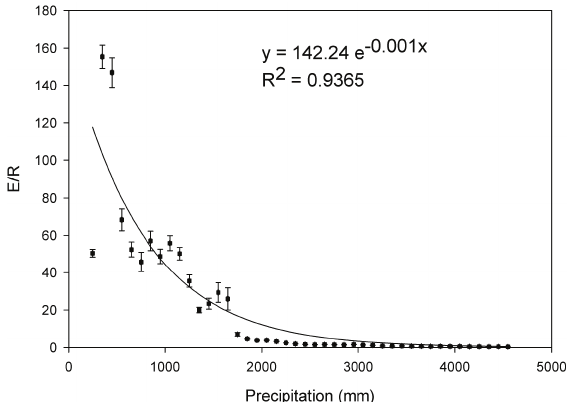
999 Fig. 10. Modeled evapotranspiration-runoff ratio (E/R) along the annual precipitation 1000 gradient across the Mesoamerican region. Each point represents a 100 mm annual 1001 Fig. 10. Modelled evapotranspiration-runoff ratio ( E/R ) along the precipitation class. Bars show standard error of each class. 1002 annual precipitation gradient across the Mesoamerican region. Each point represents a 100mm annual precipitation class. Bars show standard error of each class.